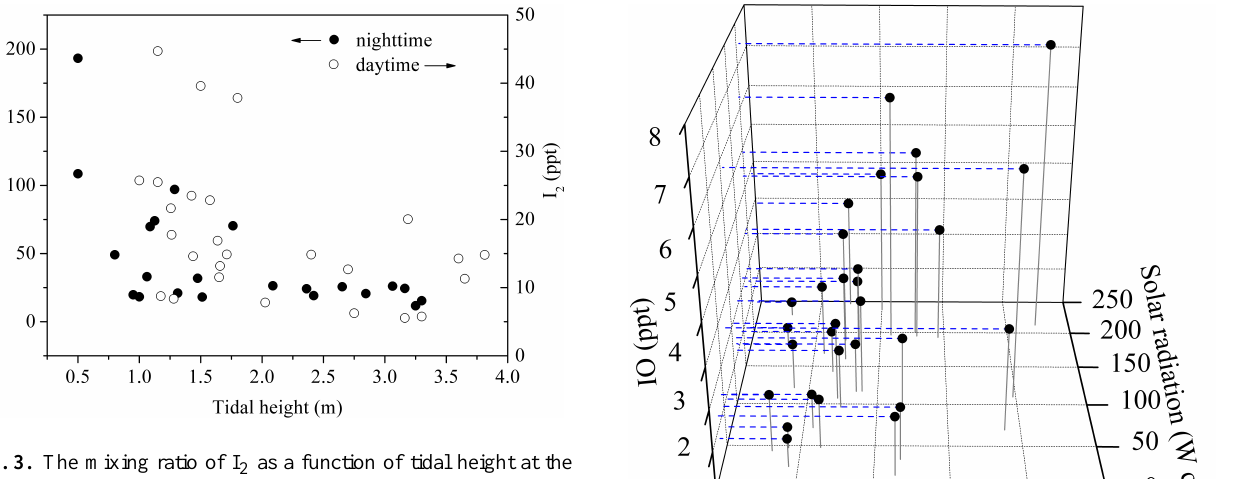
Fig. 3. The mixing ratio of I 2 as a function of tidal height at the sampling site Mweenish Bay-II.